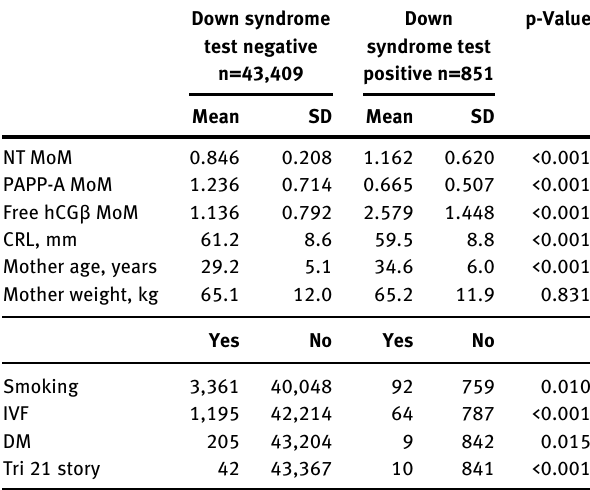
Table  : Demographic data and statistical results of positive and negative groups according to screening test results.